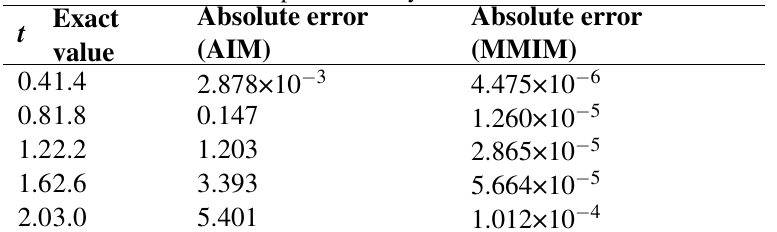
Table 2 Comparative study of AIM and